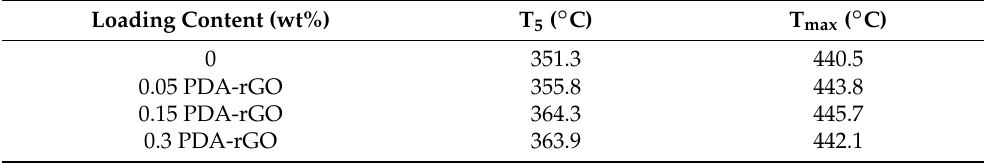
Table 3. TGA data of PA6 fiber and composite fibers containing different PDA-rGO